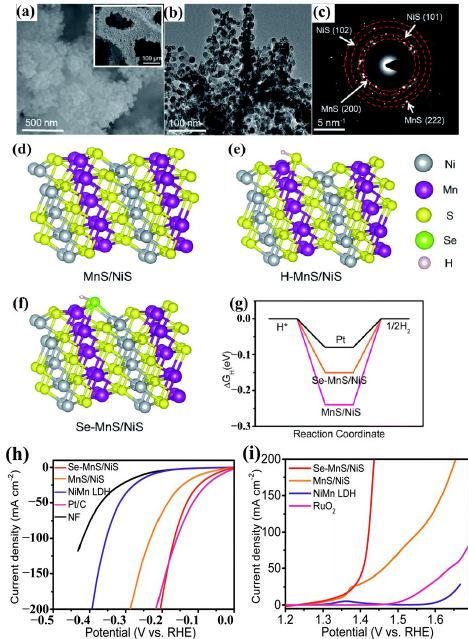
Figure 6. ( a ) SEM and ( b ) TEM images of Se-MnS/NiS. ( c ) Selected area electron diffraction (SAED) pattern of Se-MnS/NiS. ( d – f ) Structures. ( g ) Free energy diagram of HER over MnS/NiS and Se- MnS/NiS. ( h ) HER polarization curves of NiMn LDH, MnS/NiS, Se-MnS/NiS, NF, and Pt/C in 1 M KOH at 10 mV s − 1 . ( i ) OER polarization curves of Ni-Mn LDH, MnS/NiS, and Se-MnS/NiS in 1 M KOH with a scan rate of 10 mV s − 1 . Reproduced with permission from Ref. [76]. Copyright 2019, The Royal Society of